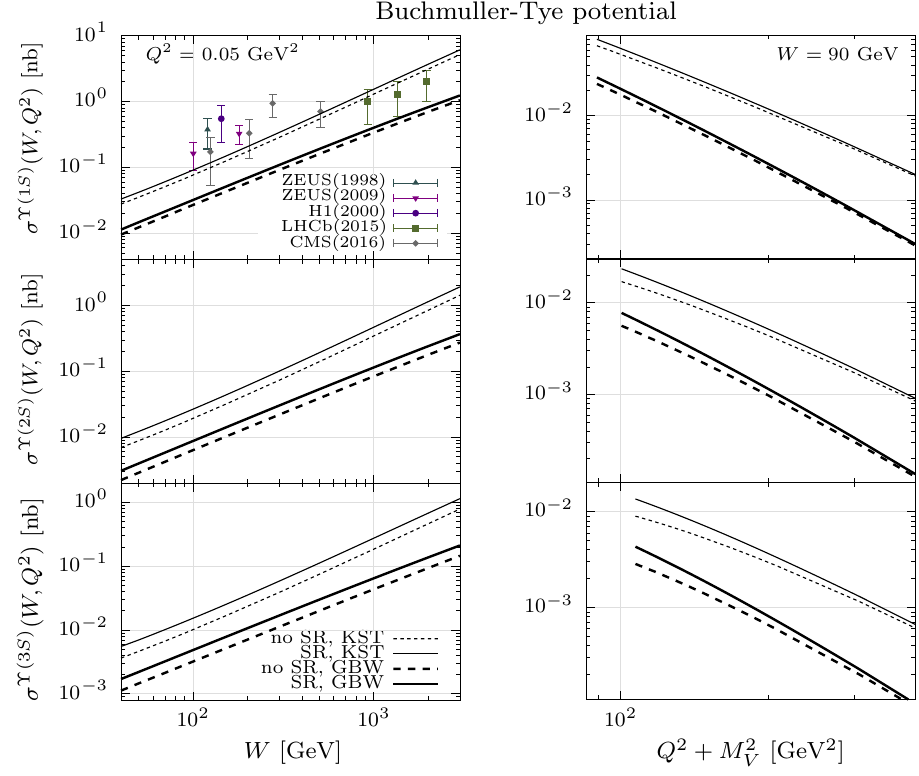
Fig. 5 The same as Fig. 3 but for elastic virtual photoproduction of ϒ( 1 S ) (upper boxes), ϒ (cid:2) ( 2 S ) (middle boxes) and ϒ (cid:2)(cid:2) ( 3 S ) (lower boxes). The experimental data for the process γ p → ϒ( 1 S ) p are taken from Refs. [28,49–52]. All model predictions have been obtained with the wave functions of ϒ( 1 S ) , ϒ (cid:2) ( 2 S )